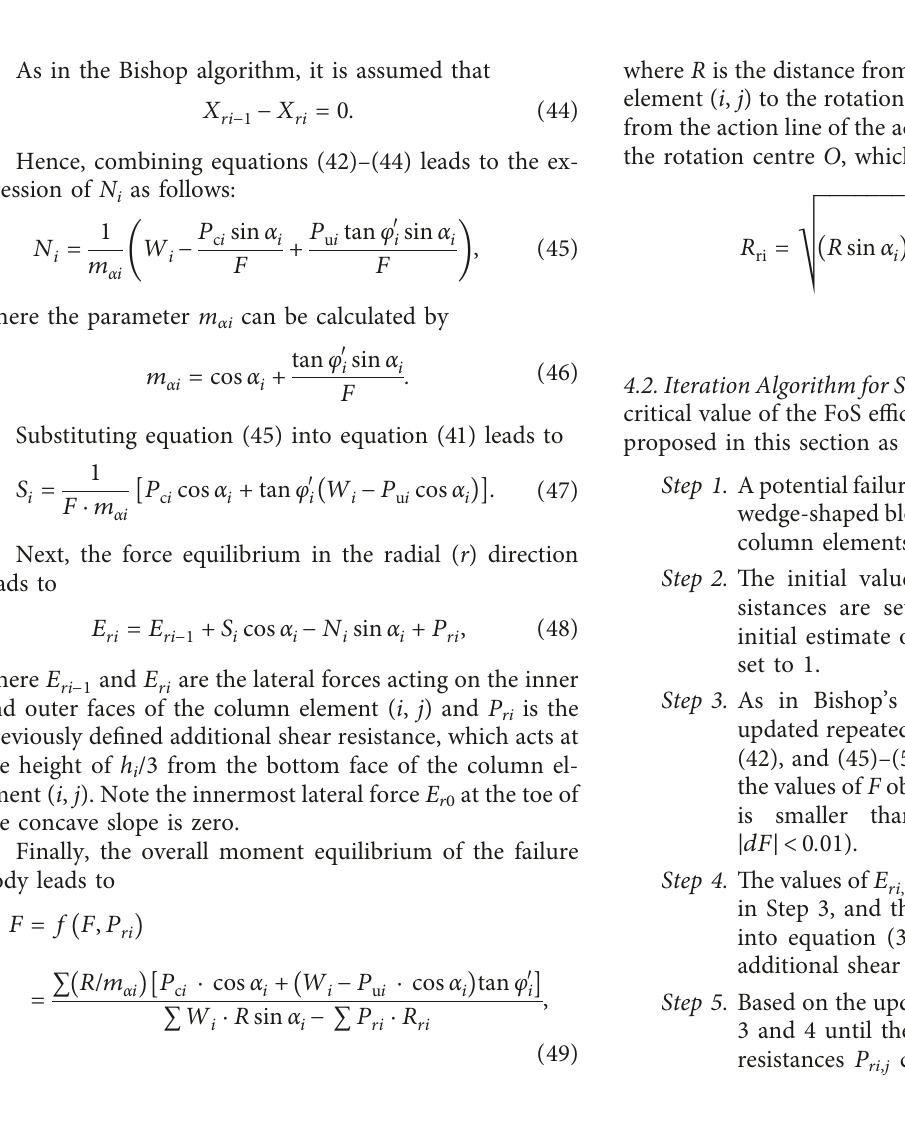
Figure 4: The j -th wedge-shaped